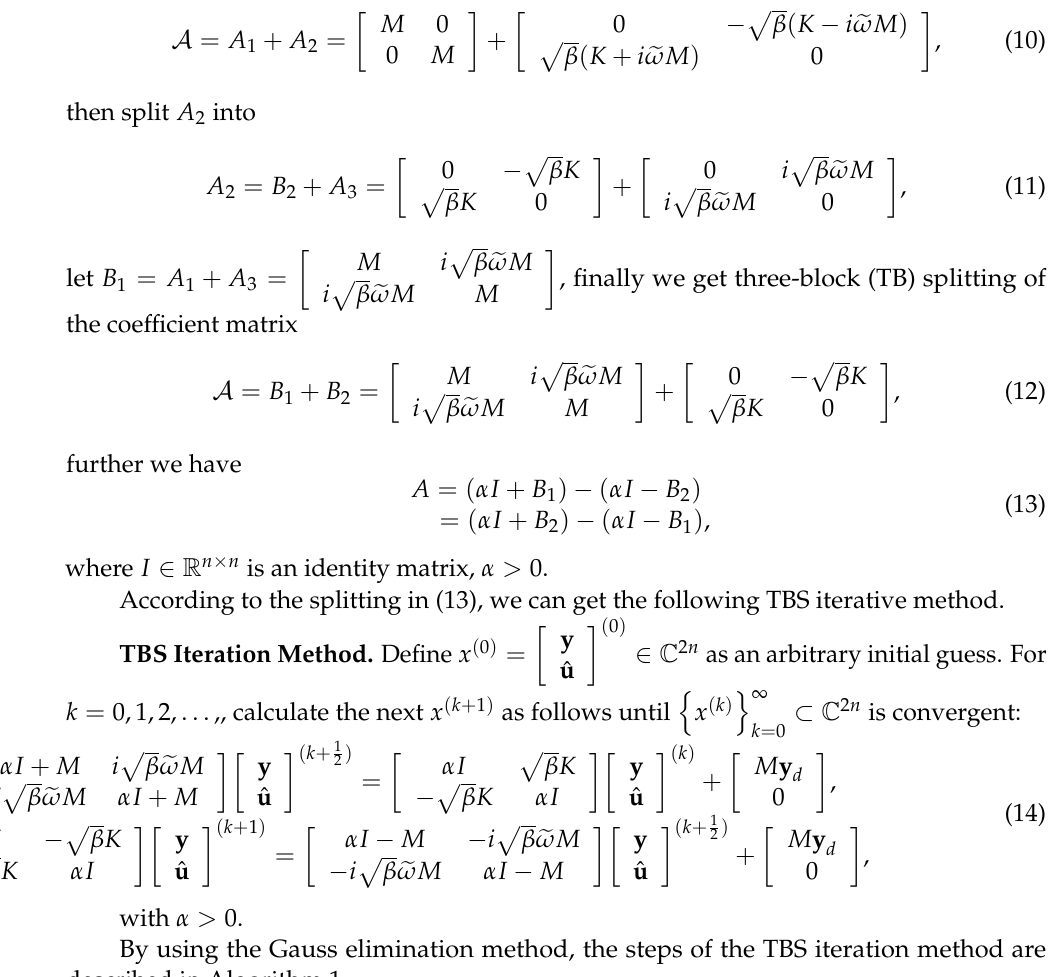
(cid:20) y (cid:21) ( k ) ∈ C 2 n , follow the procedure below to ˆ u